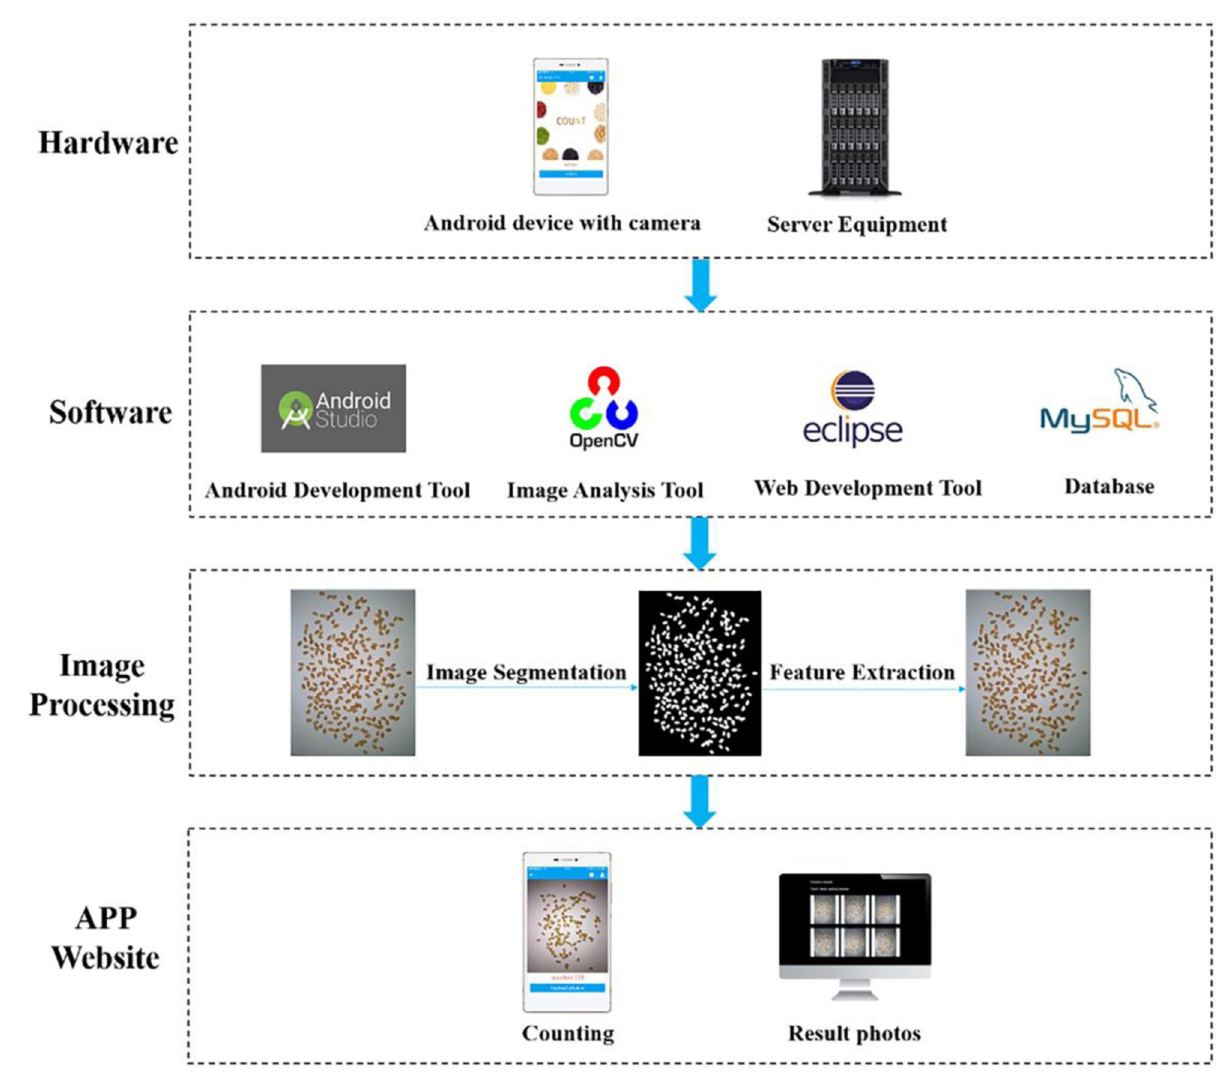
Fig 1. System implementation